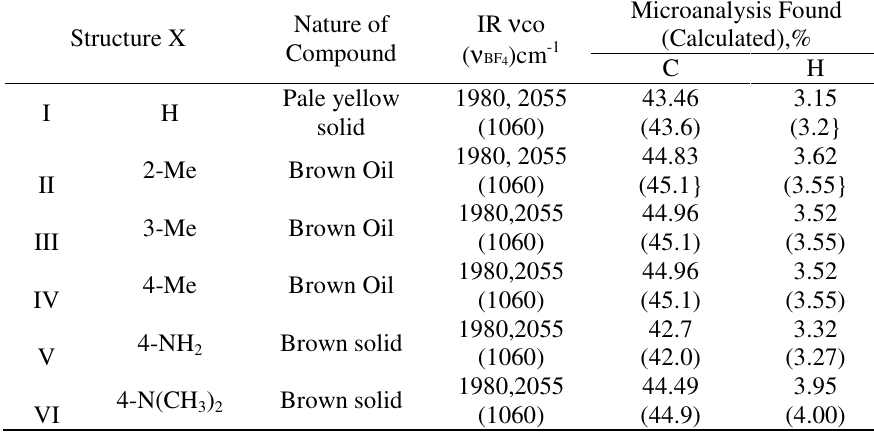
Table 1. Nature of compound, infra-red spectra data and micro analytical data for the (1, 4- η 2-methoxycyclohexa- 1-3-diene -5-exo- N -pyridino derivatives of iron tricarbonyl complexes Microanalysis